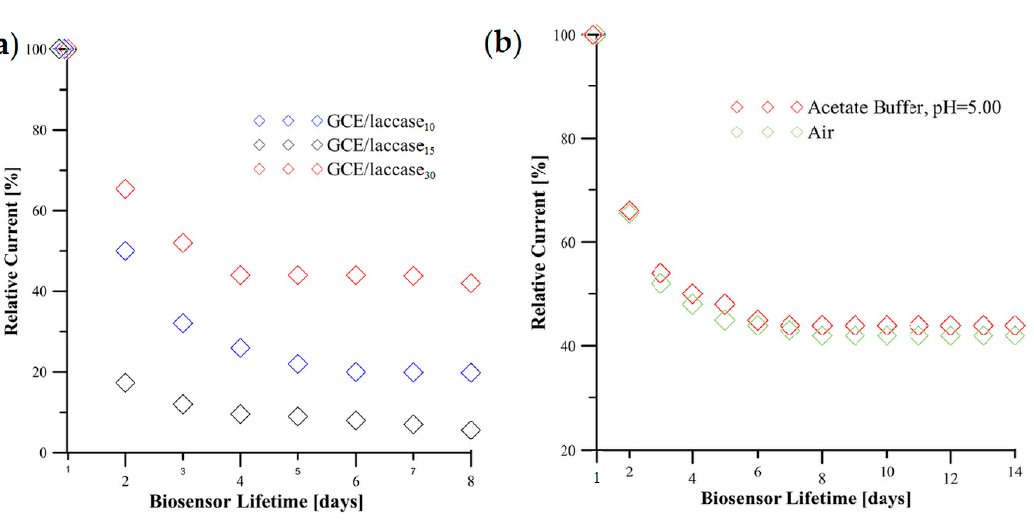
Figure 3. ( a ) Relative current (%) of GCE/laccase 10 , GCE/laccase 15 and GCE/laccase 30 vs. its lifetime (days) and ( b ) relative current (%) of GCE/laccase 30 stored in different storage conditions.